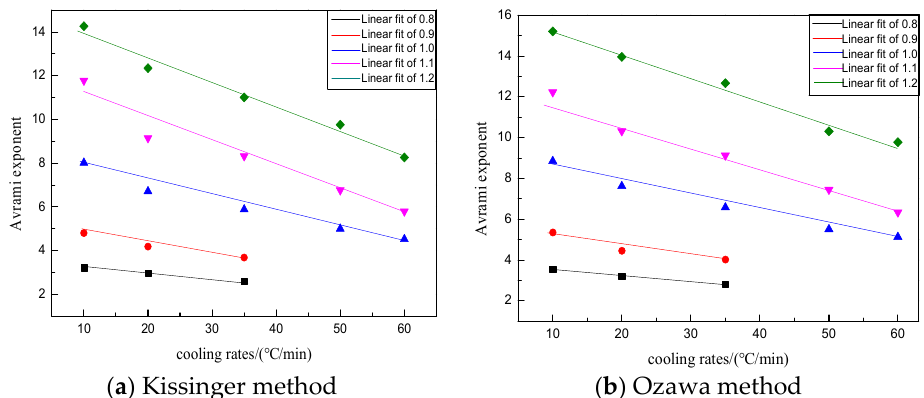
Figure 11. The influence of cooling rates on the Avrami index using different methods. ( a ) Kissinger method; ( b ) Ozawa method.